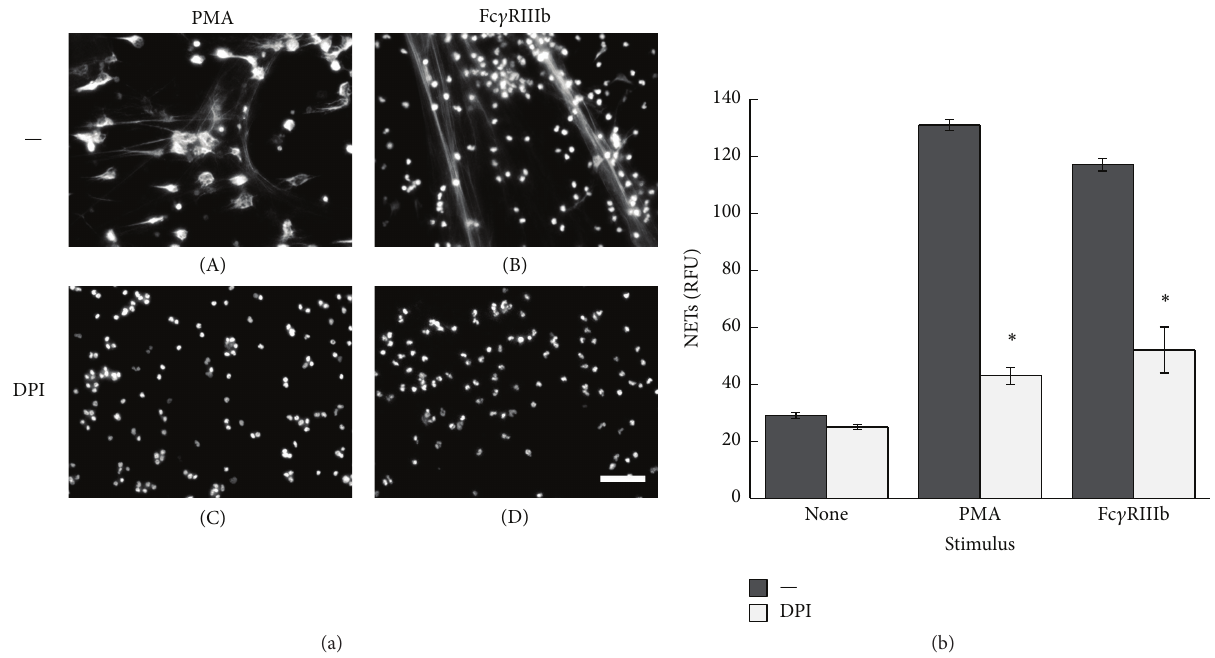
Figure 8: Fc 𝛾 RIIIb-induced NET formation is dependent on NADPH-oxidase. (a) Human neutrophils (PMN) were not stimulated (None) or were stimulated with 20nM phorbol 12-myristate 13-acetate (PMA) or by cross-linking Fc 𝛾 RIIIb with mAb 3G8. PMN were previously treated with solvent alone (—) or with the NADPH-oxidase inhibitor diphenyleneiodonium (DPI) (10 𝜇 M). After four hours, PMN were fixed and stained for DNA (DAPI). Microphotographs were taken at 200x magnification and are representative of three experiments. Bar is 50 𝜇 m. (b) The relative amount of NETs was estimated from SYTOX Green fluorescence in relative fluorescent units (RFU) at 4 hours after stimulation. Data are mean ± SEM of 5 experiments. Asterisks denote conditions that are statistically different from control ( 𝑝 < 0.001 ).